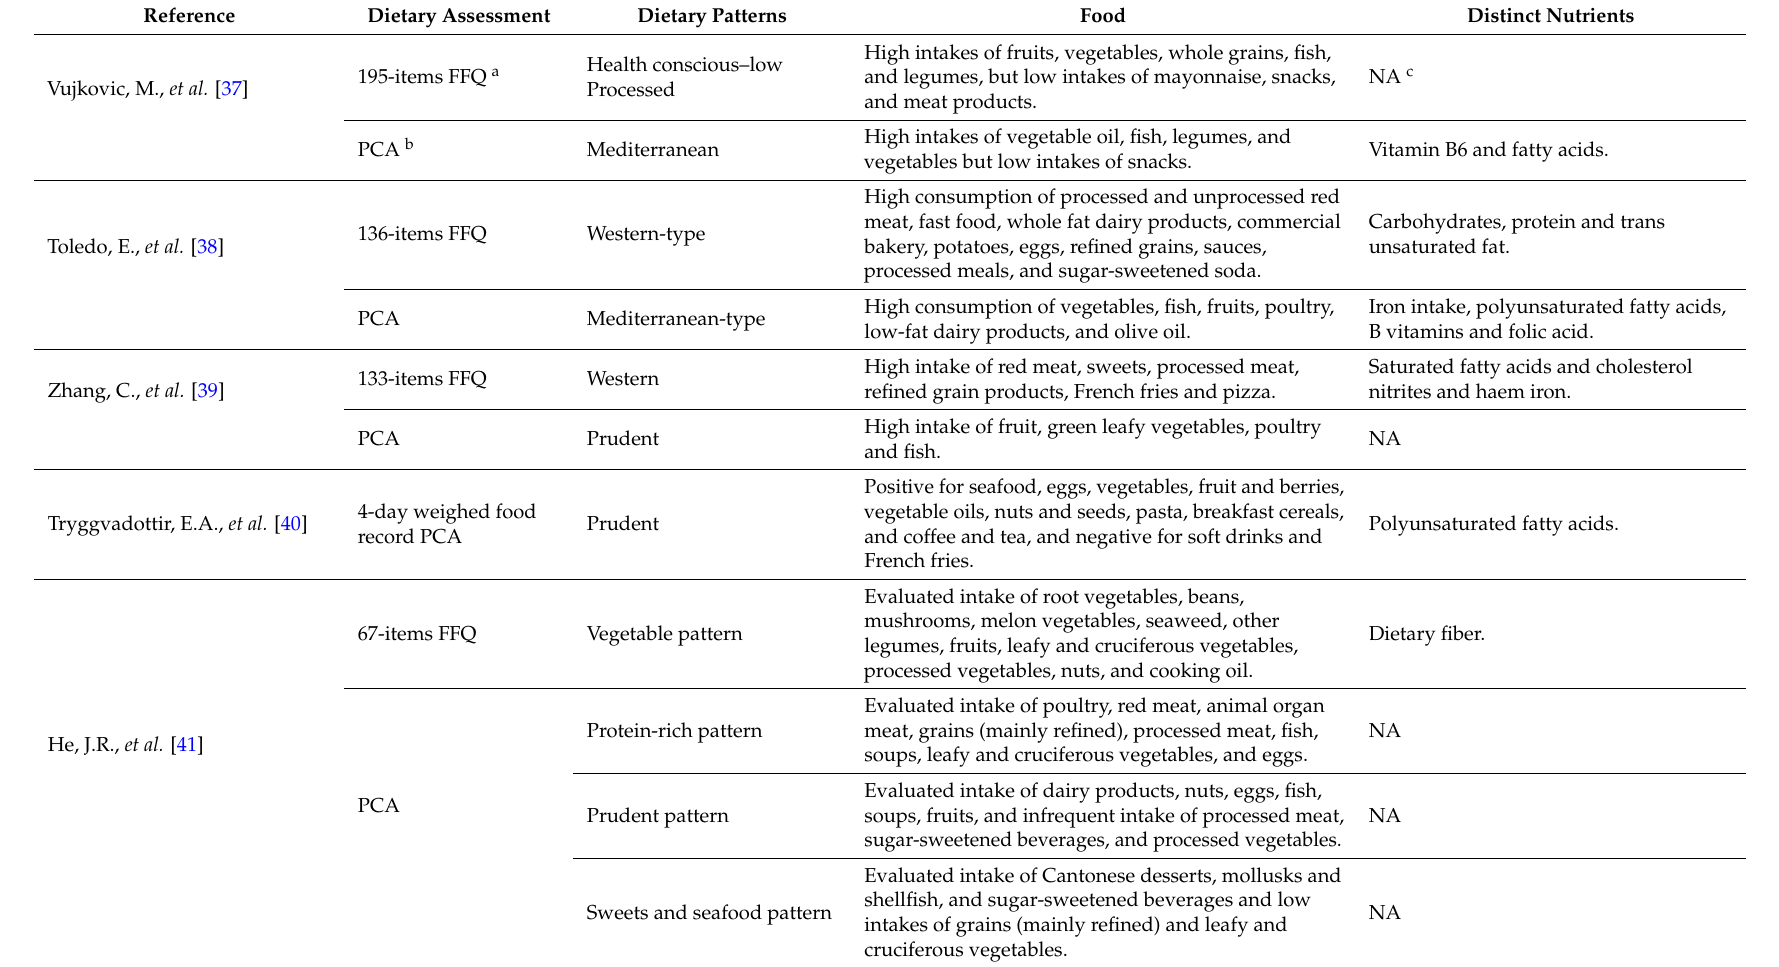
Table 2. Studies reporting dietary patterns derived from statistical